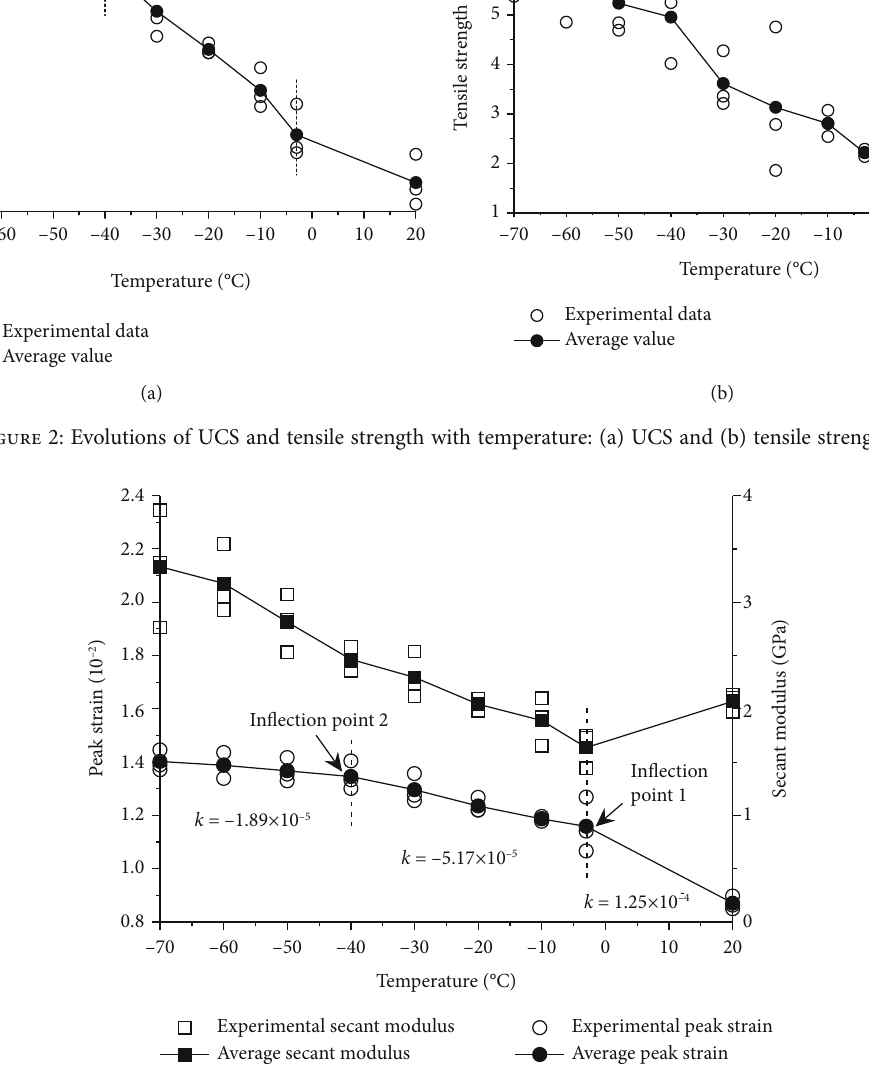
Figure 3: Evolution of peak strain and secant modulus with